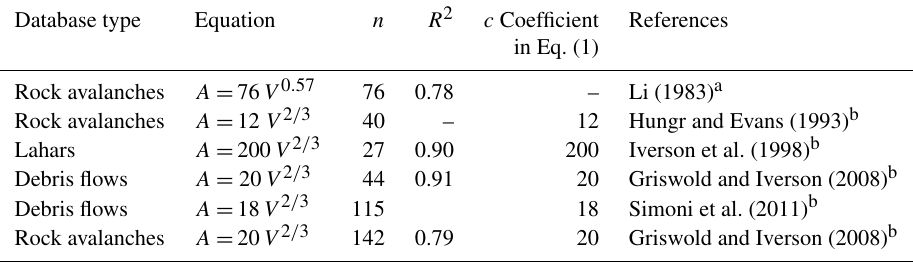
Table 2. Selected empirical relationships between volume and inundation area proposed by others for various landslide